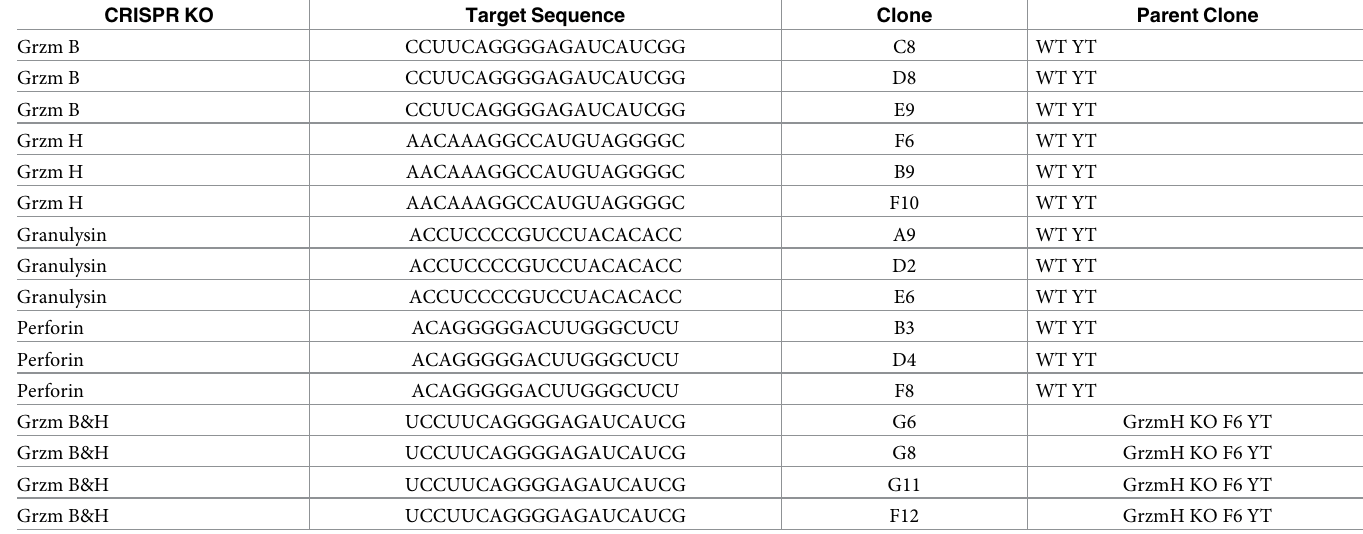
Table 2. CRISPR sgRNA sequences. CRISPR